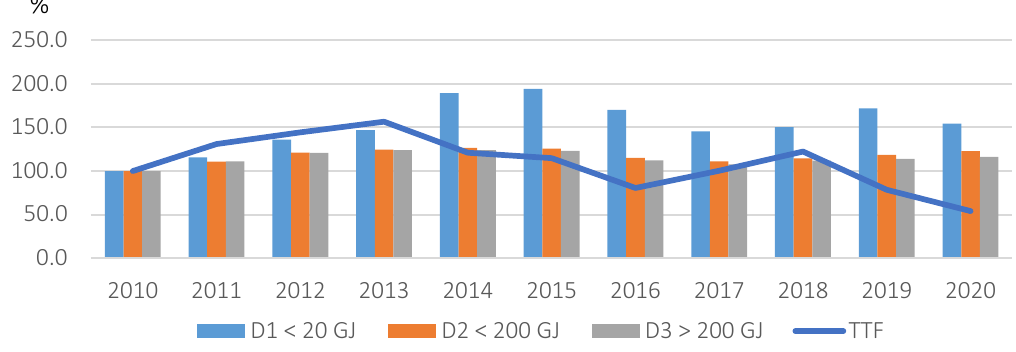
Figure 2. Change in the tariff for natural gas by category of households, including taxation in the EER countries